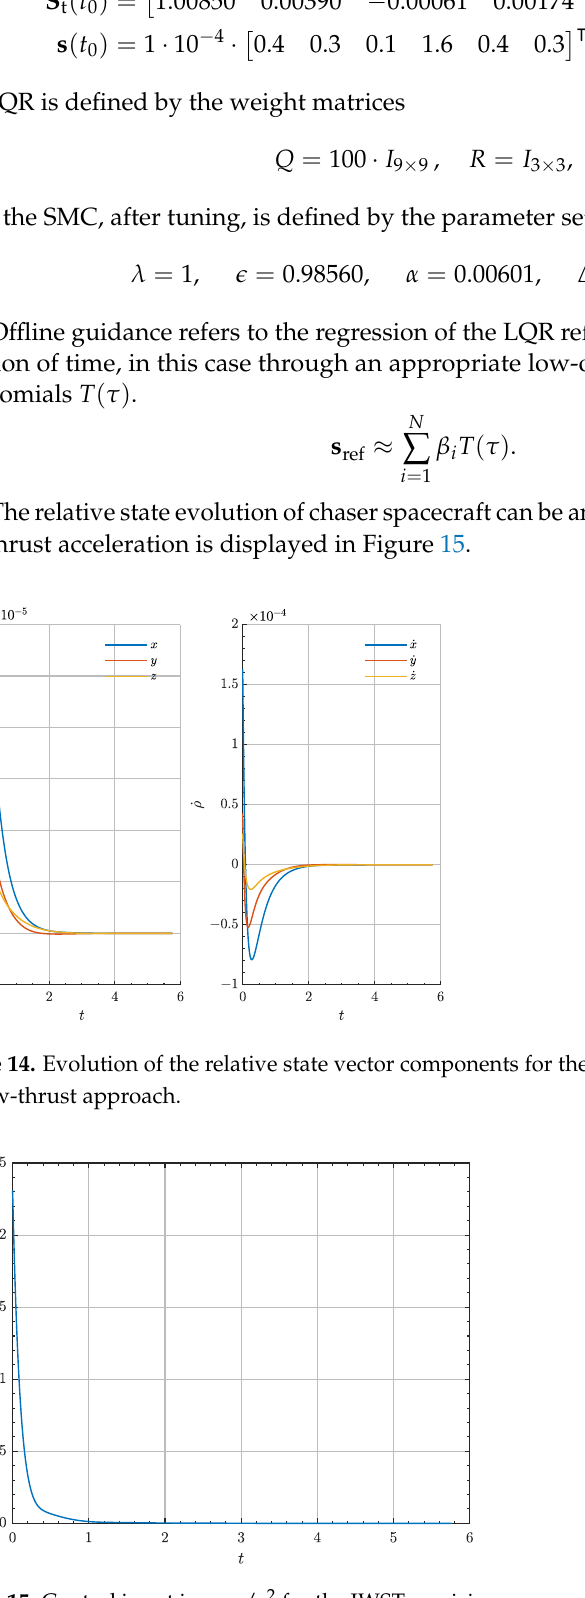
Figure 15. Control input in mm/s 2 for the JWST servicing spacecraft during the low-thrust